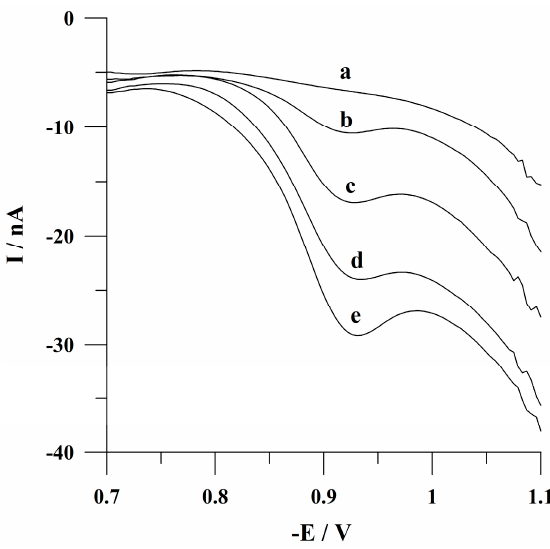
Figure 9. Square wave voltammograms obtained during analysis of certified reference material TM 25.5. (a) blank; (b) as (a) + 885 µL TM25.5 + 55.8 µL 1 mol L − 1 NaOH; (c) as (b) + 1 × 10 − 8 mol L − 1 U(VI); (d) as (c) + 1 × 10 − 8 mol L − 1 U(VI); (e) as (d) + 1 × 10 − 8 mol L − 1 U(VI). Accumulation time: 120 s.